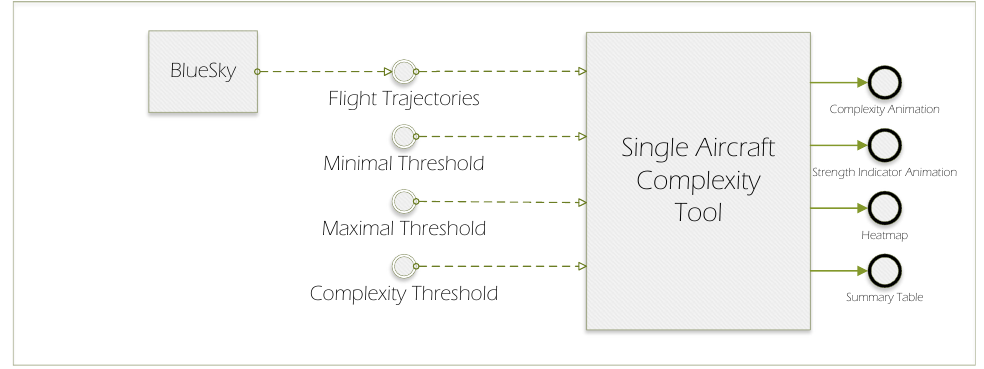
Figure 5. Workflow for visualization